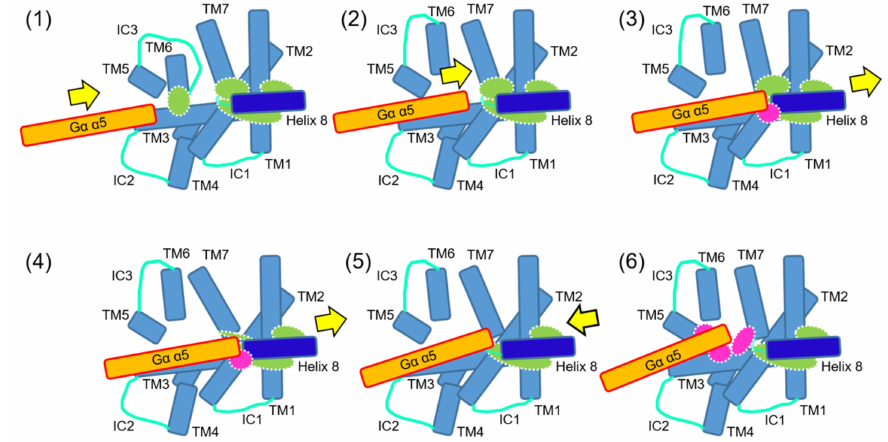
Figure 1. A transition model of multistep interactions between GPCR and G protein [10]. The cytoplasmic view of a possible sequential interaction process is shown. Intramolecular interactions (green closed circles) and intermolecular interactions (magenta closed circles) are broken, or maintained, or